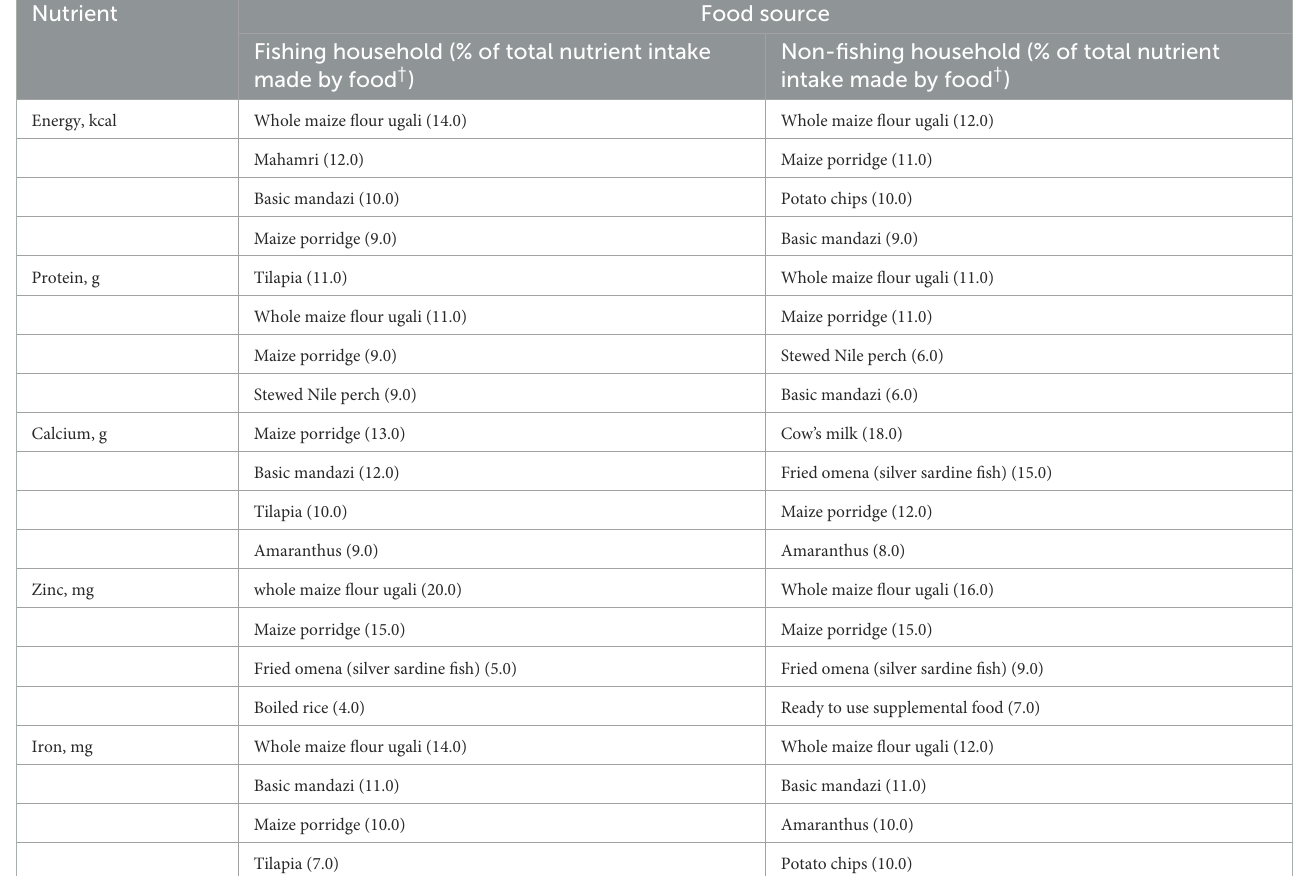
TABLE 3 Food sources with greatest contribution to key nutrients, by fishing and non-fishing households. Nutrient Food